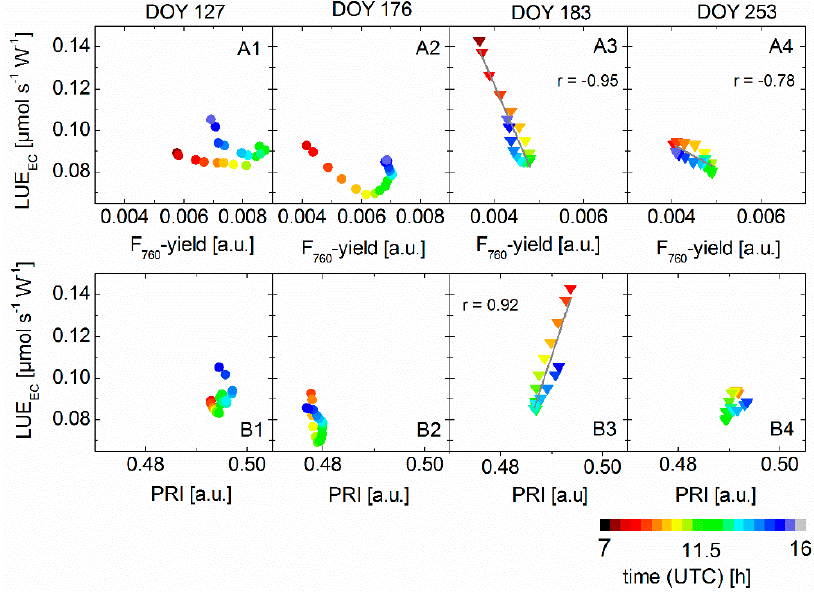
Figure 6. Light-use efficiency derived from eddy covariance (EC) observations (LUE EC ) in relation to sun-induced fluorescence yield (F 760-yield ) and photochemical reflectance index (PRI) obtained from ground-based spectroscopy for winter wheat (DOY 127, 176) and sugar beet (DOY 183, 253). Top row ( A1 – A4 ): relationship between light use efficiency (LUE EC ) and sun-induced fluorescence yield (F 760-yield ). Bottom row ( B1 – B4 ): relationship between light use efficiency (LUE EC ) and photochemical reflectance index (PRI). The color code indicates the observation time (UTC). Gray lines represent a linear model fitted to the sugar beet data, the goodness of fit is indicated with the correlation coefficient (r). All parameters of the linear model and results of the cross validation are given in Tables S2 and S3 in the supplementary materials.